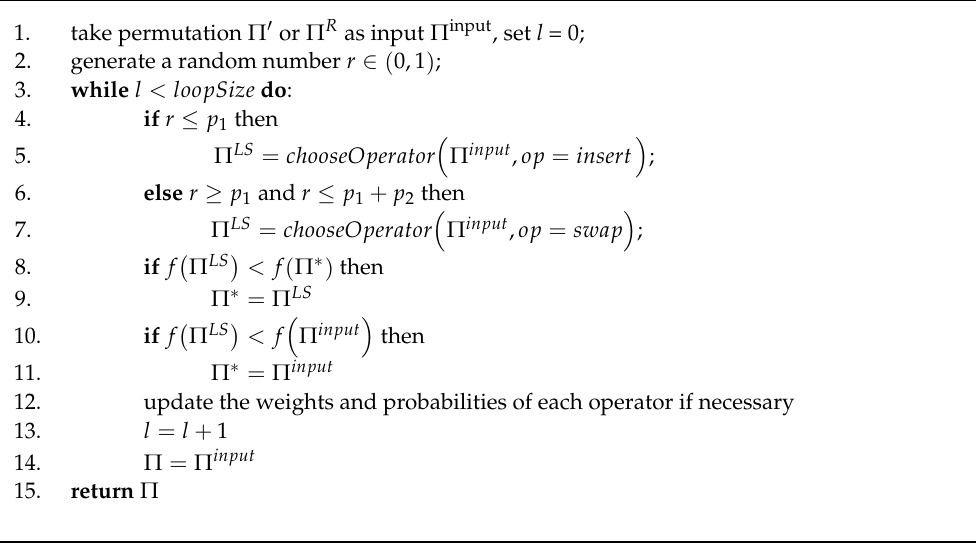
Algorithm 3 The local search framework